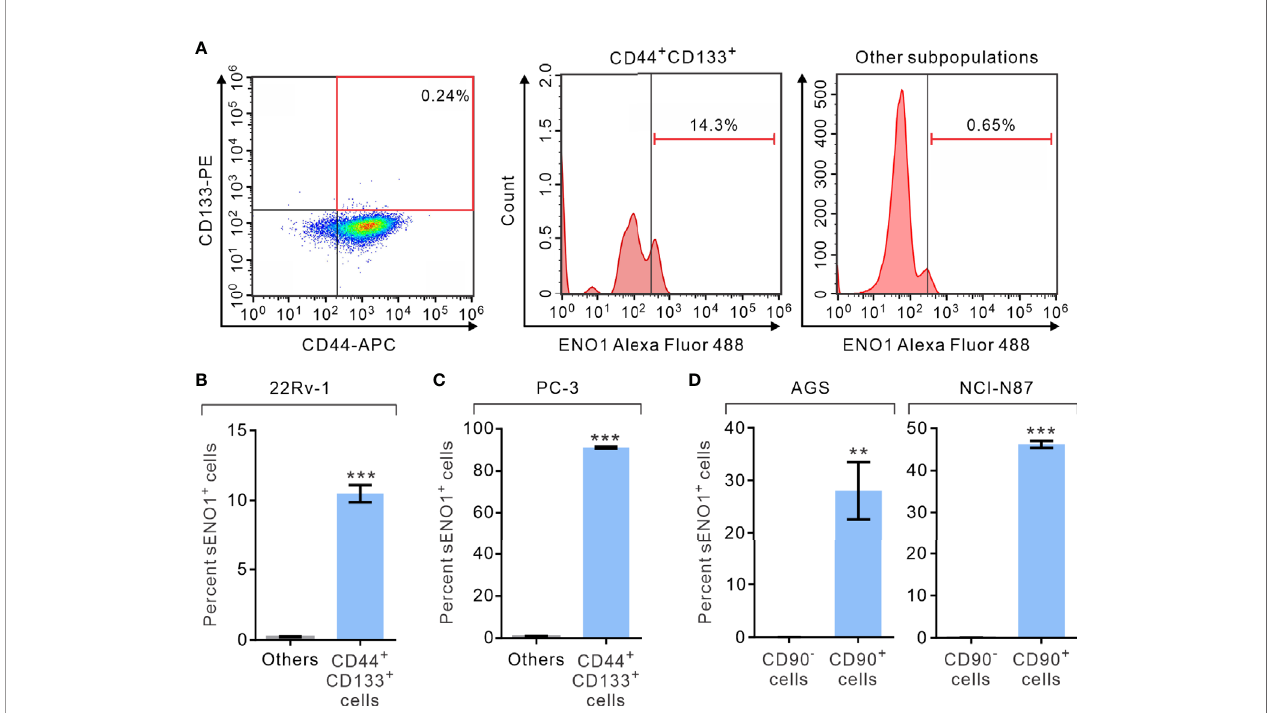
FIGURE 1 | The expression of ENO1 on the cell-surface of a subpopulation of CSCs. (A) Representative FACS plots showing patterns of CD44, CD133, and surface ENO1 (sENO1) staining of primary prostate adenocarcinoma (PAC)-derived 22Rv-1 cells with the frequency of the boxed CD44 + CD133 + cell population (representing CSCs in PAC; left) or sENO1 + cells in CD44 + CD133 + CSCs (middle) or cells in the other subpopulations (representing non-CSCs; right) shown. (B) The percentages of sENO1 + cell subpopulation in CD44 + CD133 + 22Rv-1 cells or cells in the other subpopulations (others). (C) The percentages of sENO1 + cell subpopulation in CD44 + CD133 + PC-3 cells or cells in the other subpopulations. (D) The percentages of sENO1 + cell subpopulation in CD90 + gastric adenocarcinoma (GAC) AGS or NCI-N87 cells (representing CSCs in GAC) or CD90- cells (representing non-CSCs). Error bars represent mean ± SEM from three independent experiment (n = 3). Unpaired t-test was performed throughout where **p < 0.01; ***p < 0.001 in (B – D)